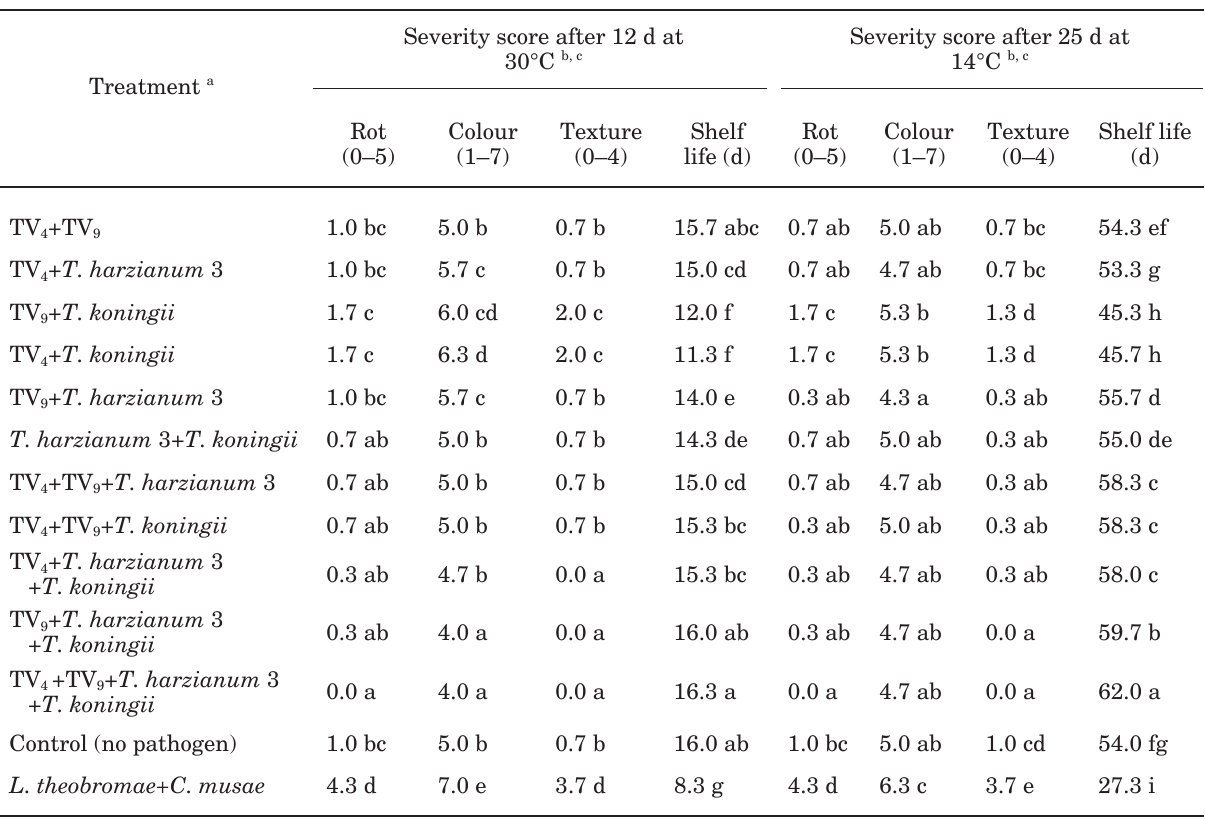
Table 5. Mean crown rot severity, colour and texture scores, and mean shelf life, for banana fruit cv. Robusta sprayed with different mixtures of Trichoderma spp.